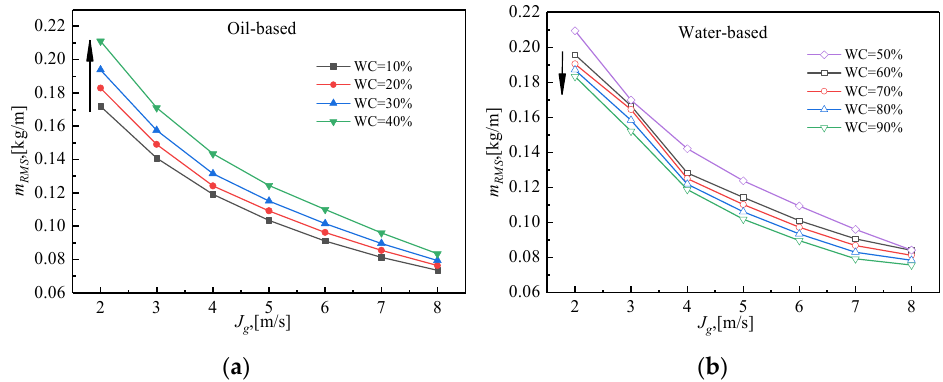
Figure 8. m RSM variation with WC at J L = 1.5 m/s, J g = 2.0–8.0 m/s: ( a ) Oil-based; ( b ) Water-based.